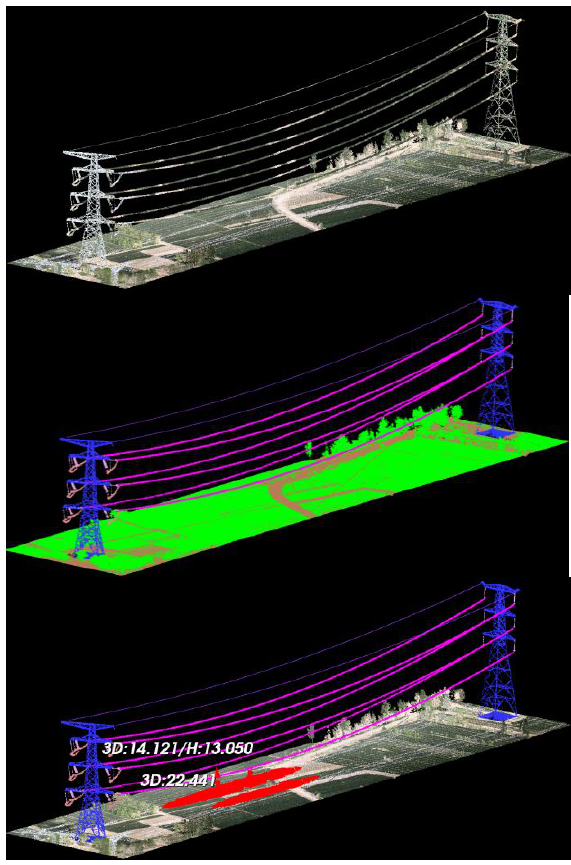
Figure 4. Test result of a 1000 KV power line span (from top to bottom: original laser point cloud; colored point cloud; after classification; highlighted risk regions)